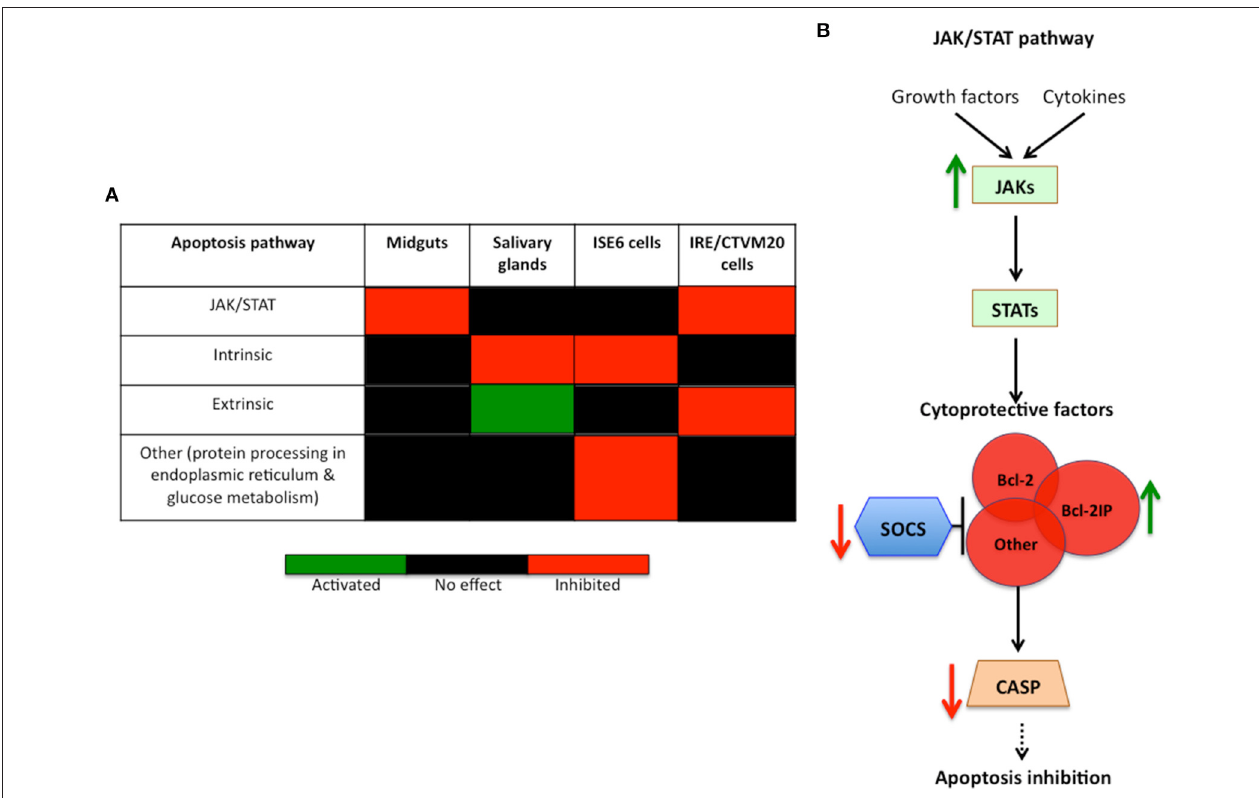
FIGURE 7 | Tissue-specific signatures in the inhibition of tick cell apoptosis by A. phagocytophilum . (A) Tissue-specific response in the inhibition of tick cell apoptosis by A. phagocytophilum . The annotation of JAK/STAT pathway genes and the effect of A. phagocytophilum infection on tick tissue response were